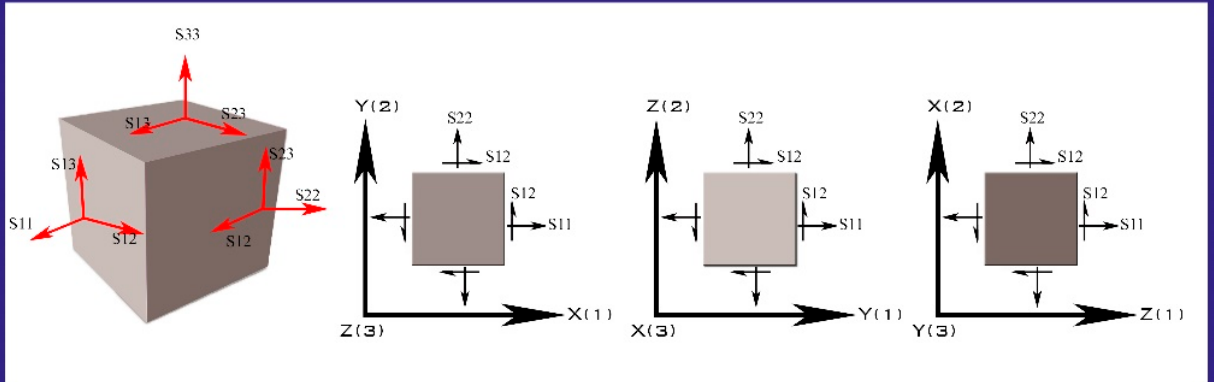
Figure 17. Sign convention in the analyses. As indicated in Figure 17: S11: vertical stress in (x) direction, S22: axial stress in (y) direction, S33: axial stress in (z) direction, (S12 = S21): shear stresses in x–y plane. While